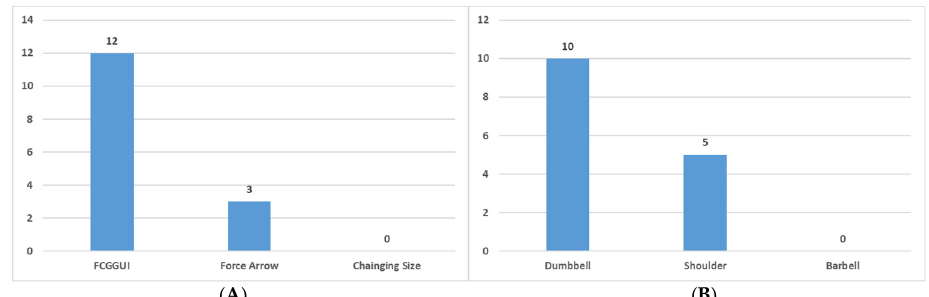
Figure 19. Results of the number of participants about the preference questions ( A ) answer to pref- erence question of pseudo-haptic interface ( B ) answer to questions of two-handed lifting curl.